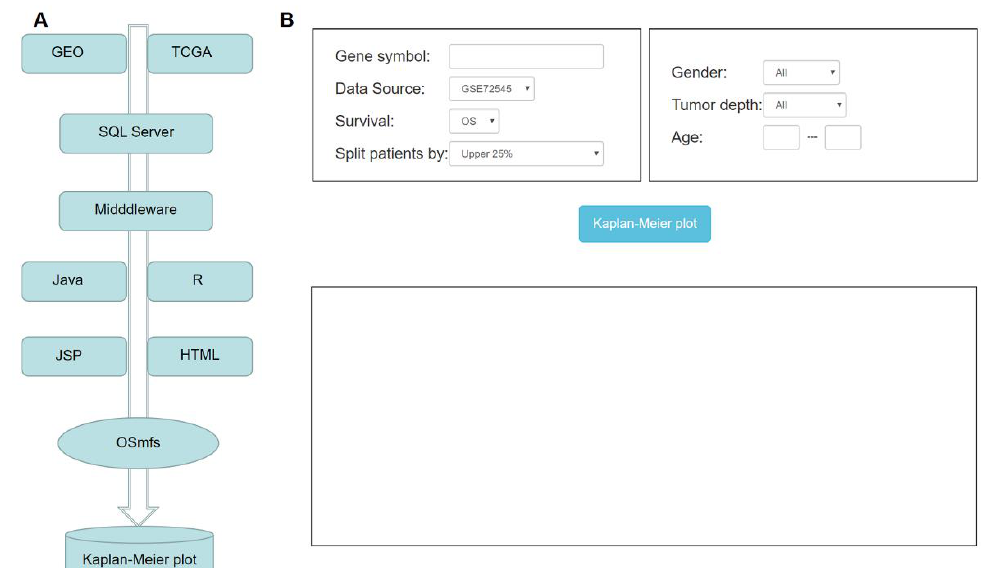
Figure 1. The System flow diagram and operation interface of OSmfs. ( A ) System flow diagram of OSmfs construction. ( B ) The input interface of prognosis analysis in OSmfs.